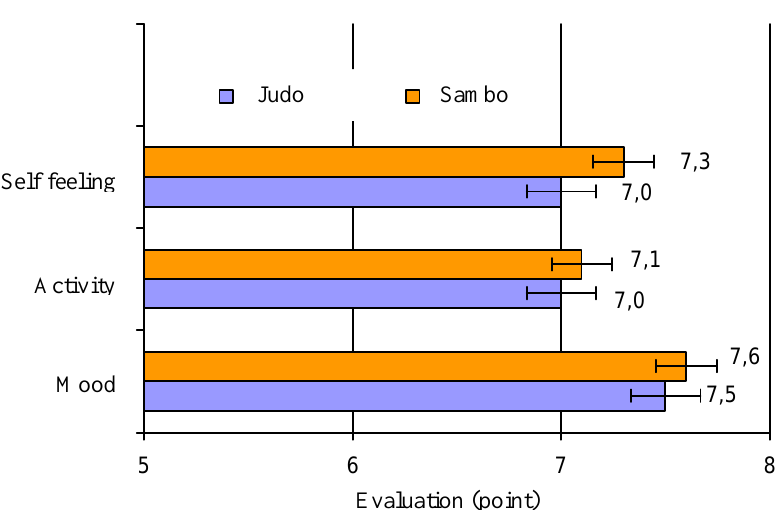
Fig.1. Evaluation of sportswomen’s state in the day of competition ( x ± xS ).